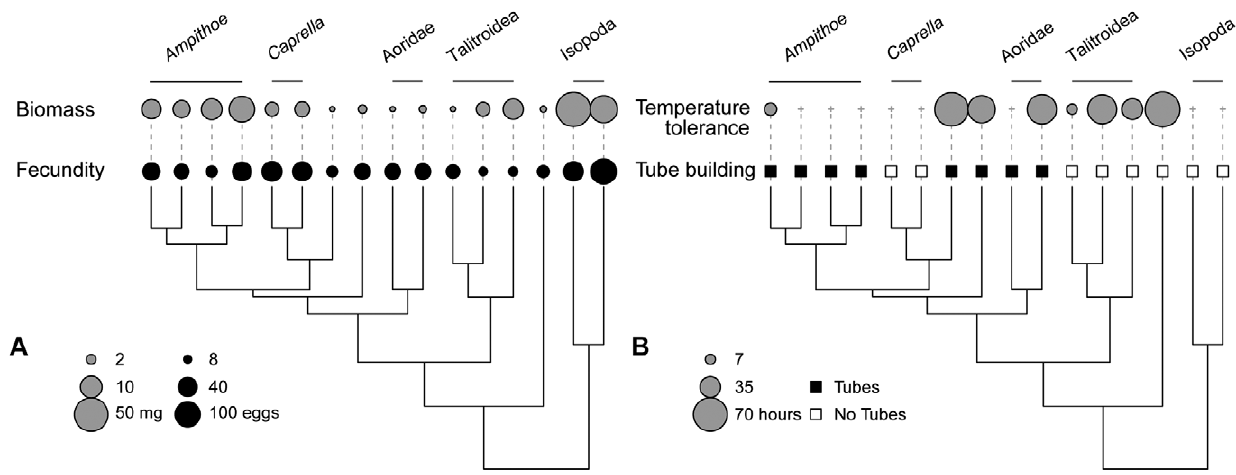
Figure 5. Relationship between phylogeny and A) biomass and fecundity, B) temperature tolerance and tube building. In A) larger circles represent higher biomass (dry weight) and fecundity (eggs per female) on log scales. In B) temperature tolerance is measured as the reduction in average survival time in the elevated temperature treatment (25 u C) compared to controls. Larger circles indicate a larger effect of elevated temperature (i.e., lower tolerance). Species with non-significant effect of treatment (using survival analysis) have the effect set to 0 (this is indicated by a + sign). Additional figures with both means and standard errors for each trait are available as supplementary material (Figure S1).